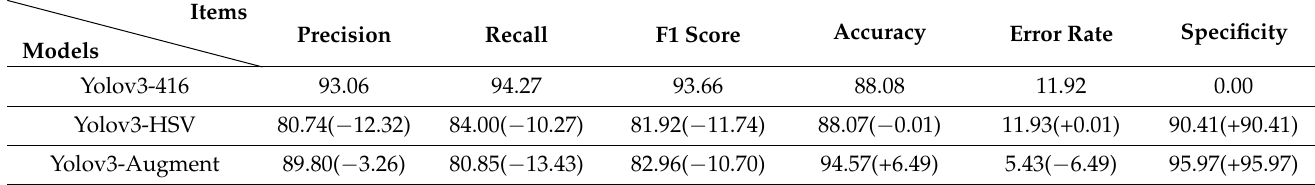
Table 4. The macro average performance of the AI models (units: %).